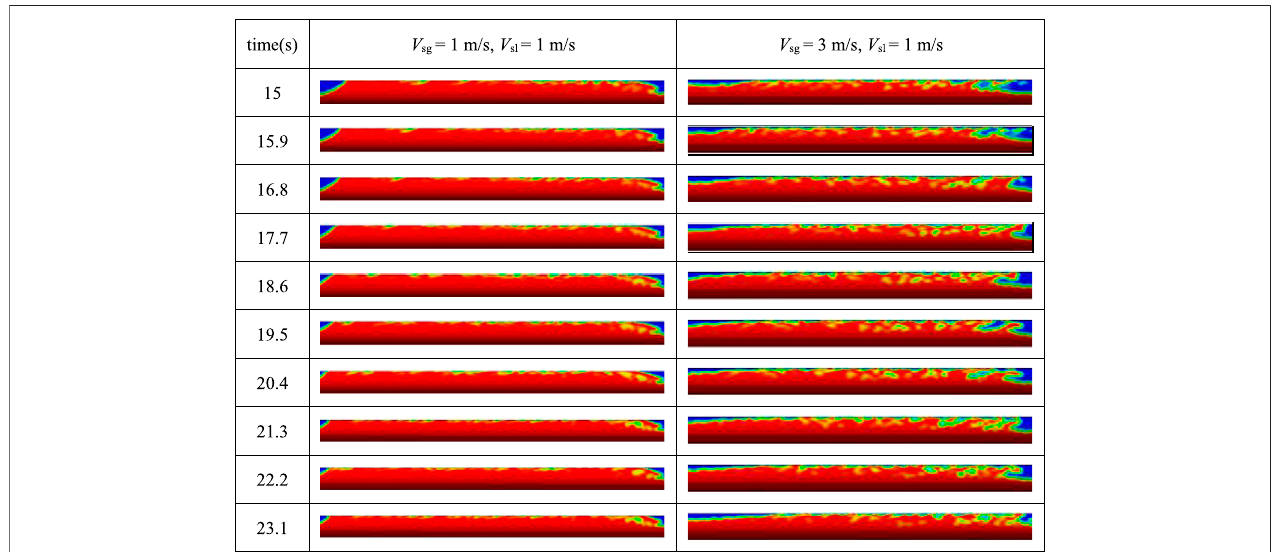
FIGURE 14 | Variation of a fully-developed slug with time with increasing gas-liquid speed difference.